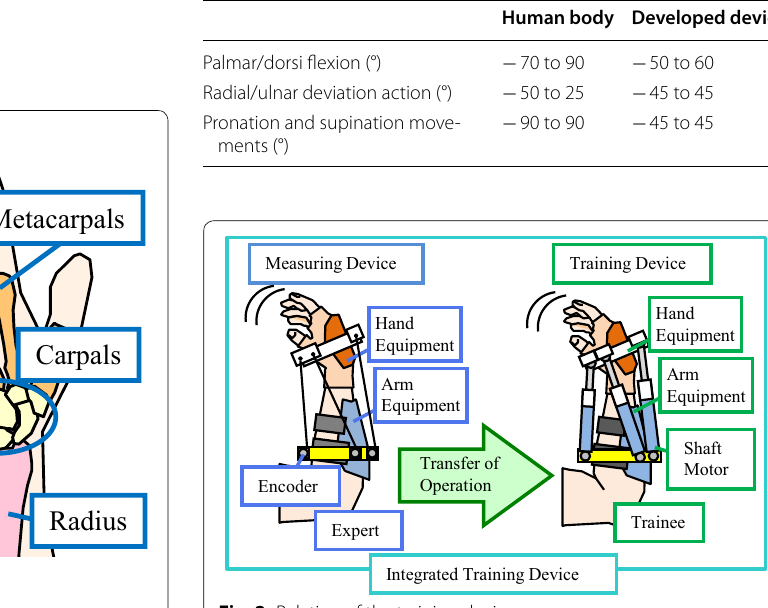
Fig. 1 Structure of the wrist joint